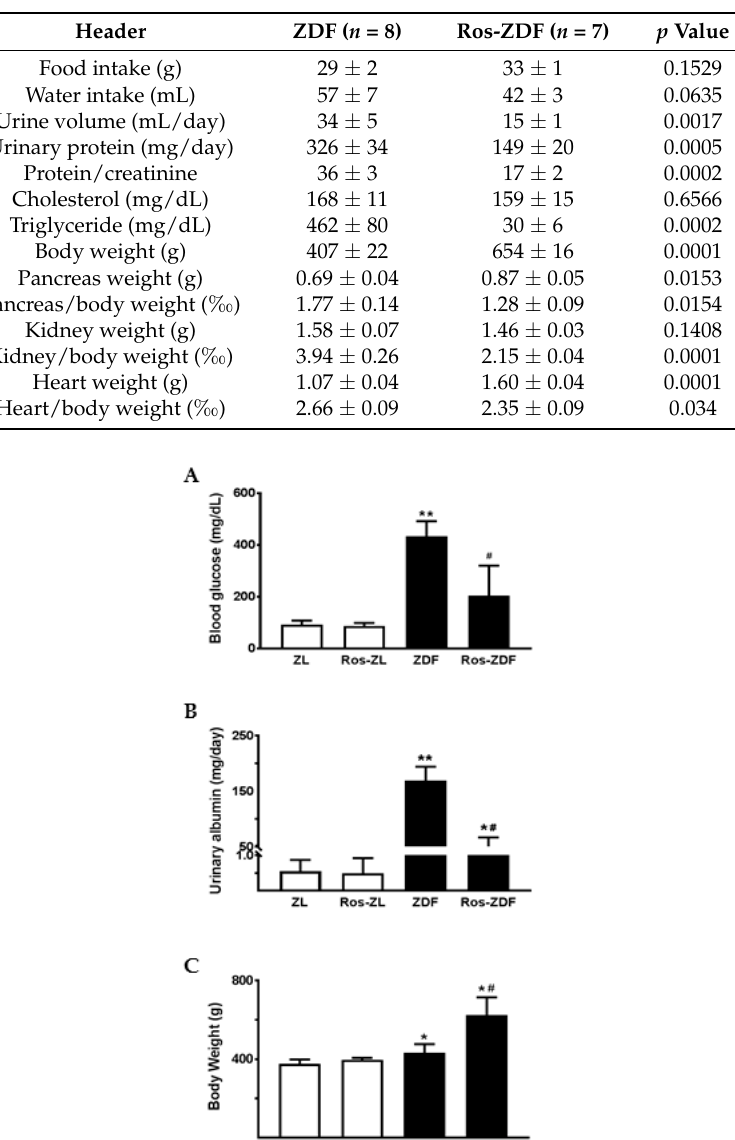
Table 1. General metabolic parameters of vehicle-treated Zucker diabetic fatty (ZDF) and rosiglitazone (Ros)-treated ZDF rats.